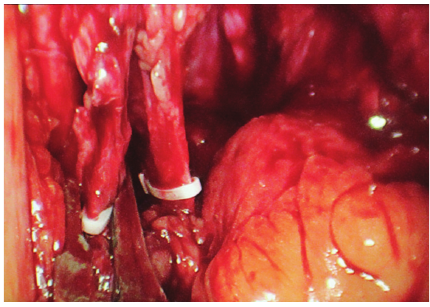
Figure 2: Single incision multiple port placed supra umbilical region.